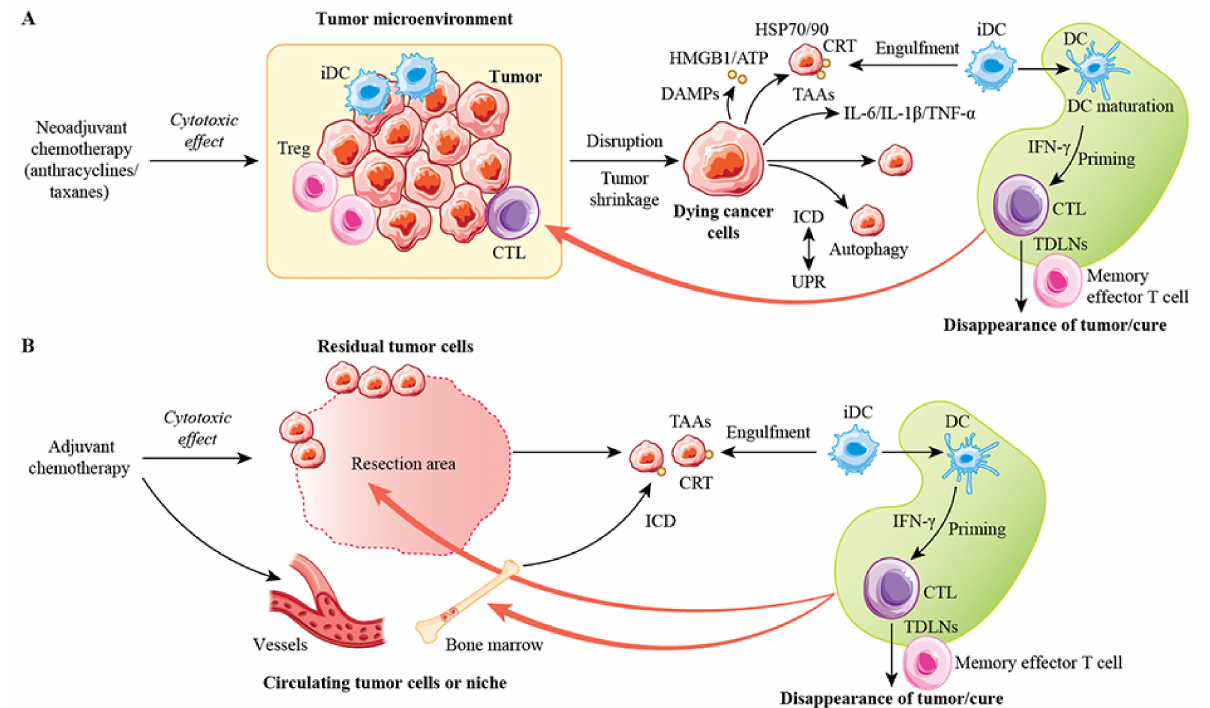
Figure 4. Hypotheses for the means by which immune activation leads after (neo)adjuvant chemotherapy to the curing of primary breast cancer. ( A ) A model of the hypothesis that immune activation after neoadjuvant chemotherapy eradicates tumor cells to cure breast cancer. Anticancer agents such as anthracyclines and taxanes are cytotoxic to tumor cells, disrupt the tumor microenvironment, induce ICD, and cause DAMP processes such as CRT membrane exposure, ATP secretion, and HMGB1 release from dying tumor cells into the extracellular environment. These processes lead to tumor-specific immune activation with the release of pro-inflammatory cytokines such as IL-6, IL-1 β , and TNF- α , which alters the immunosuppressive microenvironment and promotes immune activation. Dying cancer cells with exposed CRT containing TAAs are taken up by iDCs, causing DC maturation and CD8+ T cell activation, which in turn generates CTLs in TDLNs. These CTLs may be recruited to the primary tumor site to eradicate tumor cells, which in turn produce memory effector T cells to prevent recurrence. ( B ) A model demonstrating the efficacy of adjuvant chemotherapy in the eradication of residual tumor cells adjacent to surgical resection sites and persistent micrometastases circulating in peripheral blood vessels and distant organ niches. Adjuvant chemotherapy has cytotoxic effects on residual tumor cells and dying cancer cells, with the exposure of CRT containing TAAs that are taken up by iDCs, leading to DC maturation, the induction of CD8+ T cells, and the activation of CTLs in TDLNs. These CTLs may be recruited to the resection site, blood circulation, and distant organs to eradicate remaining tumor cells and reliably treat breast cancer. Regardless of whether chemotherapy is neoadjuvant or adjuvant, tumor-specific immune activation via ICD by anticancer agents can completely eradicate residual tumor cells and contribute to long-term outcomes in patients with primary breast cancer by providing permanent immunity with memory effector T cells to prevent recurrence. Abbreviations: TDLN, tumor-draining lymph node; UPR, unfolded protein